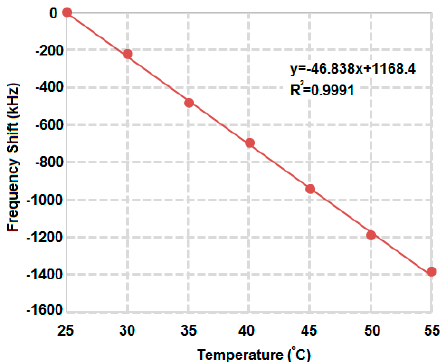
Figure 25. Measured SAW device resonance frequency shift against the environment temperature using the presented readout circuit.